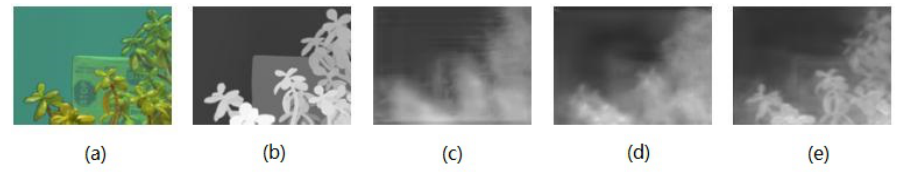
Figure 14. Transmission map estimation results using different modules. ( a ) underwater images; ( b ) ground truth; ( c ) U-shaped structure (DFCRN); ( d ) U-shaped structure + multi-scale estimation; ( e ) U-shaped structure + multi-scale estimation + cross layer connection(our T-network).